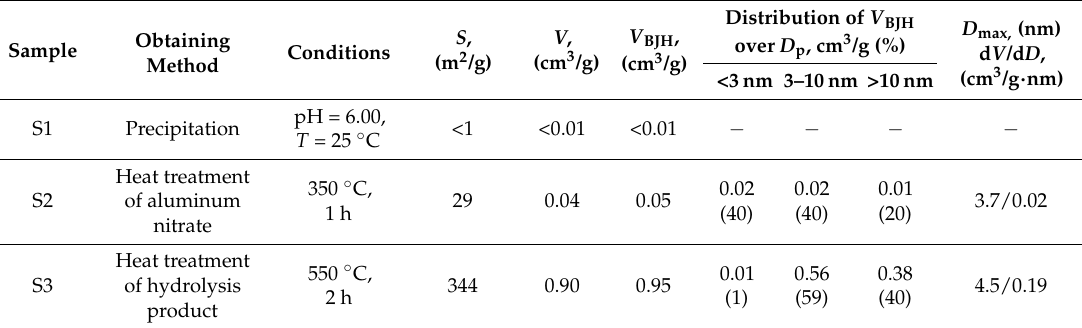
Table 4. Porous system parameters of amorphous compounds S1–S3.